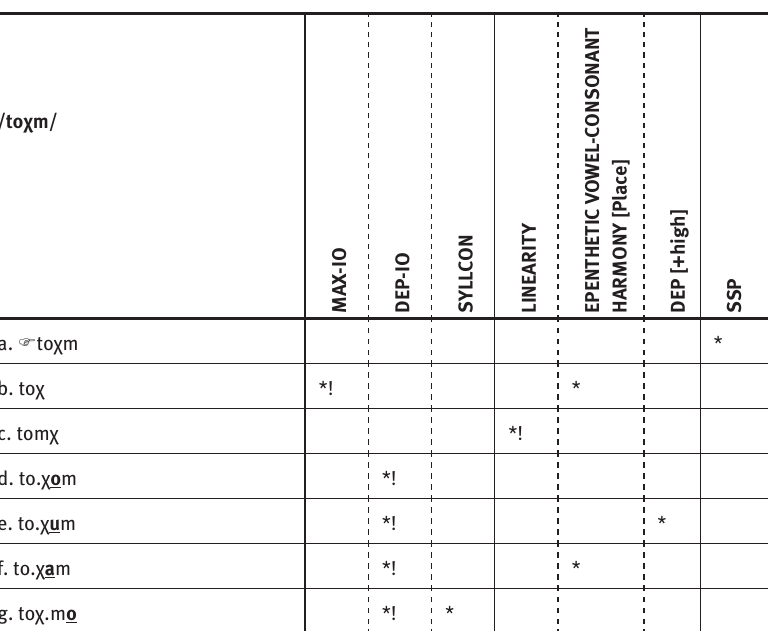
Table 16 : MAX-IO, DEP-IO, SYLLCON, CONTIG C-Fricative, CONTIG C-Lateral >>LINEARITY, EPENTHETIC VOWEL-CONSONANT HARMONY [Place], DEP